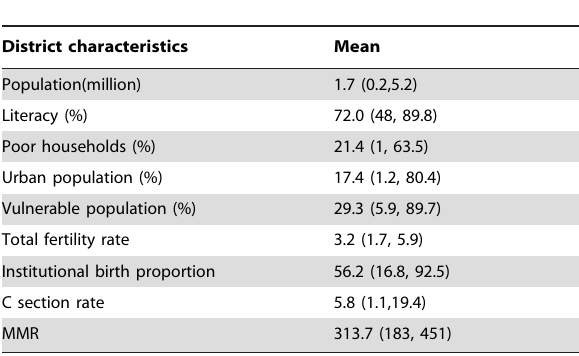
Table 1. Characteristics of 284 study